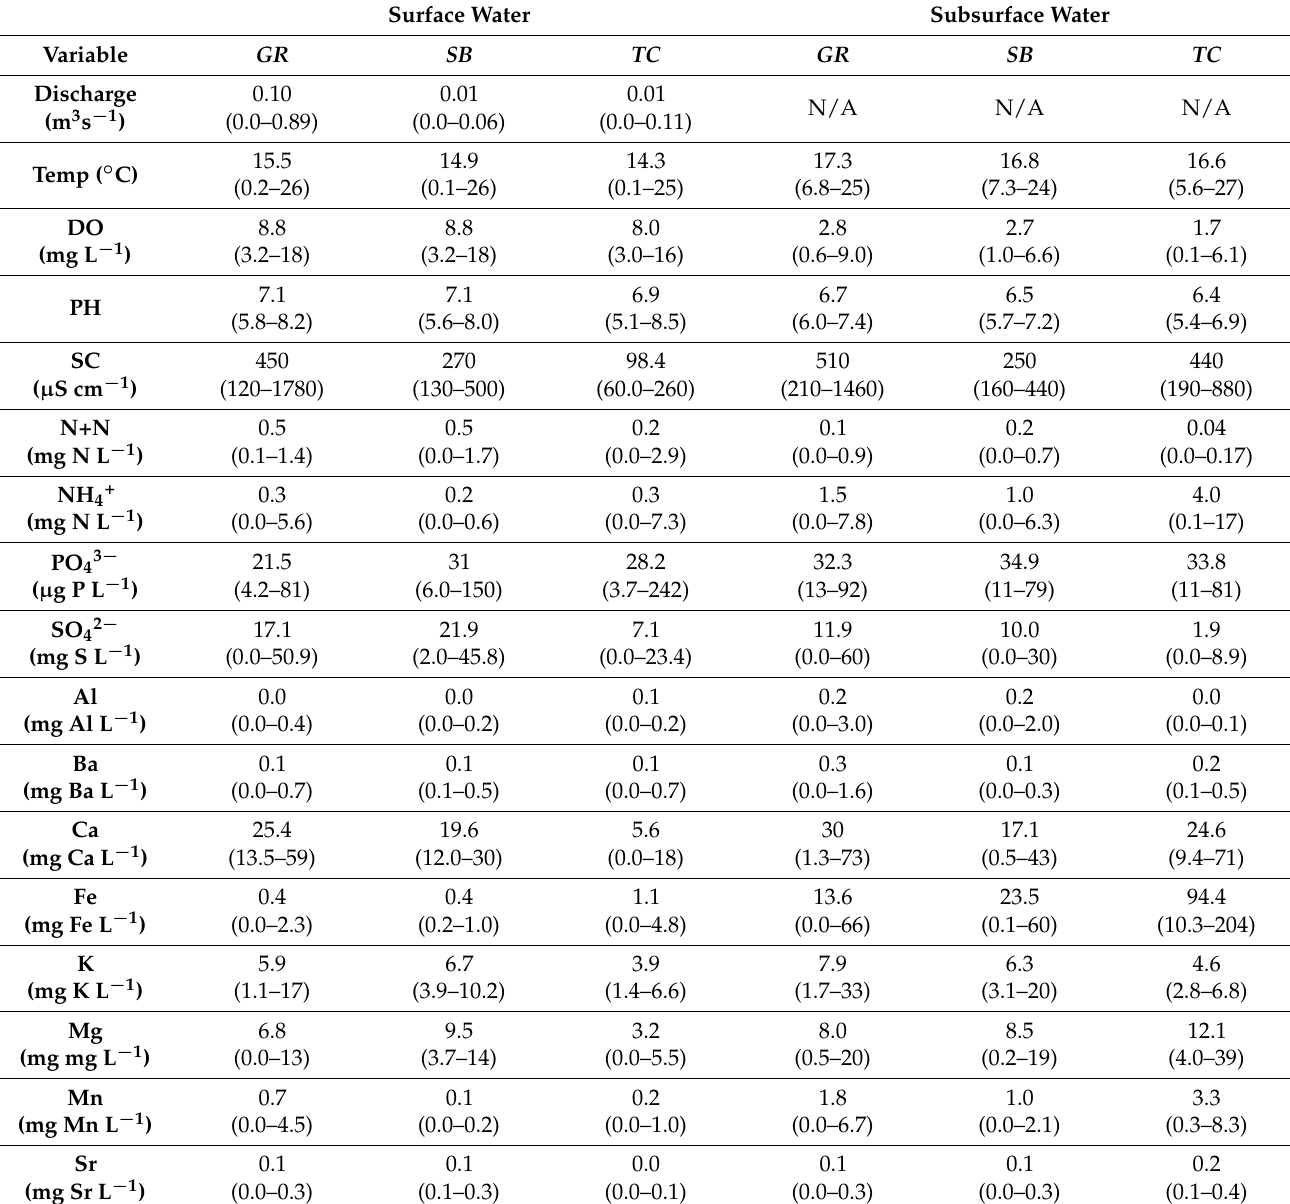
Table 2. Average (min–max) of variables measured during weekly sampling within each stream system. Both surface water (n = 88) and subsurface water (n = 32) measurements are included. N/A (not available) indicates the parameters were not